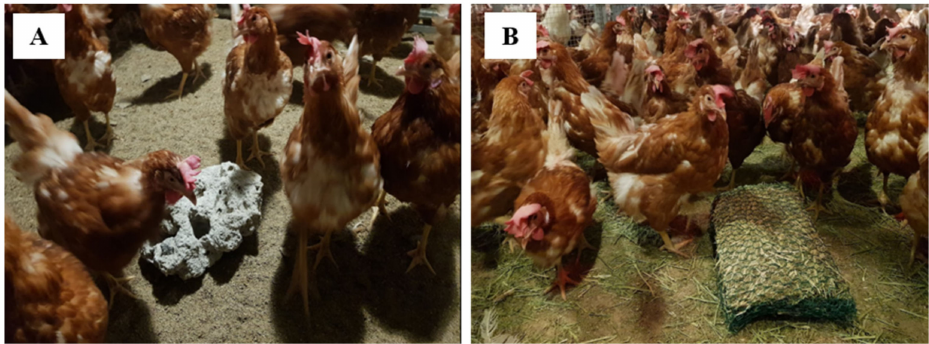
Figure 1. Environmental enrichment through different types of pecking materials. ( A ) Pumice stone; ( B ) alfalfa